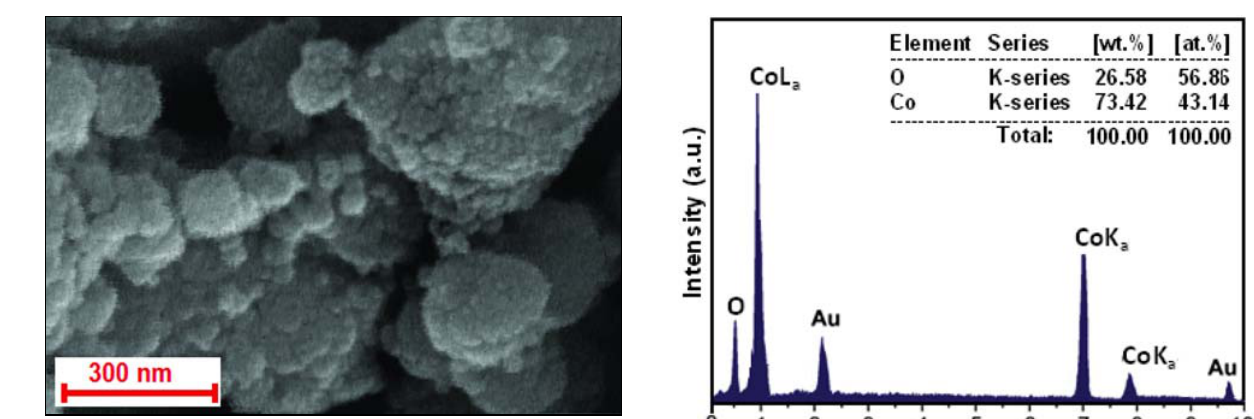
Figure 5. SEM image of the Co